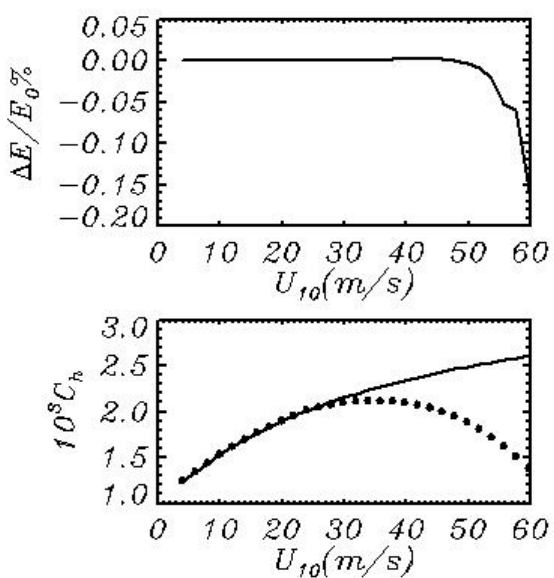
Figure 17. The influence of energy of the high-frequency part of spectrum on drag coefficient. In upper panel the reduction of wave energy (%) due to truncation of the spectral tail is shown. The bottom panel shows the undisturbed dependence of drag coefficient (solid curve) and a drag coefficient calculated at the truncated spectrum (dots).